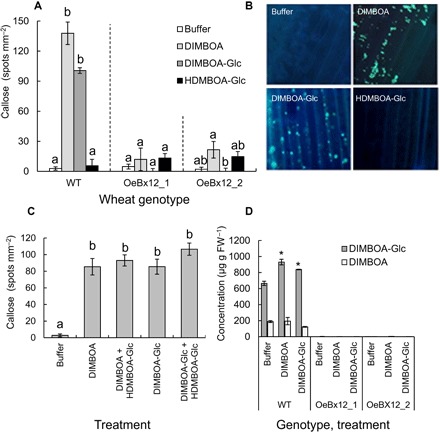
Callose suppression through DIMBOA-Glc O-methylation.(A) Induction of callose in WT and ZmBx12-overexpressing lines after infiltration with DIMBOA, DIMBOA-Glc, or HDMBOA-Glc (n = 4 to 11). (B) Representative photographs of callose induction in WT plants after aniline blue staining. (C) Callose induction in WT plants treated with different benzoxazinoid mixtures (n = 5 to 11). (D) Concentration of DIMBOA-Glc (dark gray bars) and DIMBOA (light gray bars) in the leaves of WT and transgenic plants infused with DIMBOA-Glc or DIMBOA (n = 3). Different letters and asterisks indicate significant differences between treatments within lines (ANOVA followed by Holm-Sidak post hoc tests, P < 0.05). Photo credit for (B): B. Li, University of Bern.